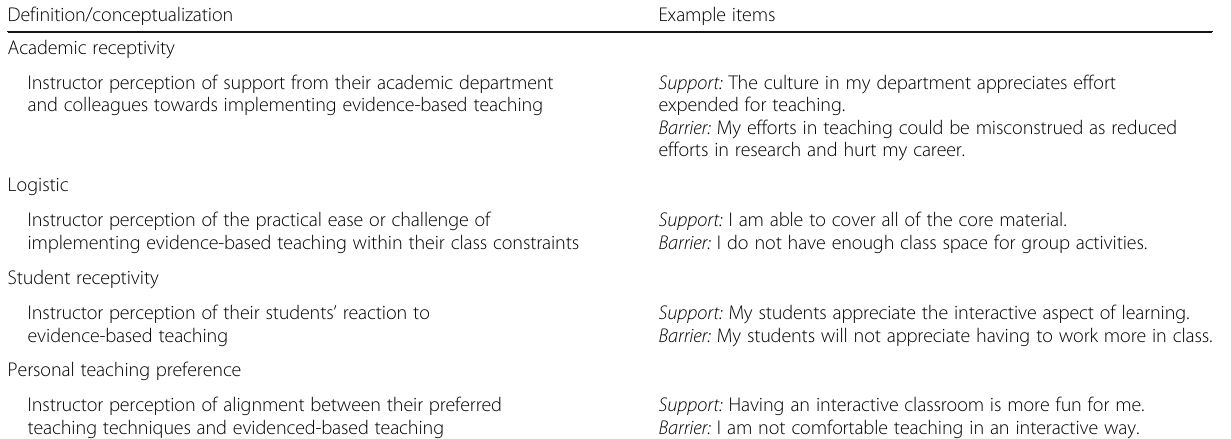
Table 1 Categories for barriers and